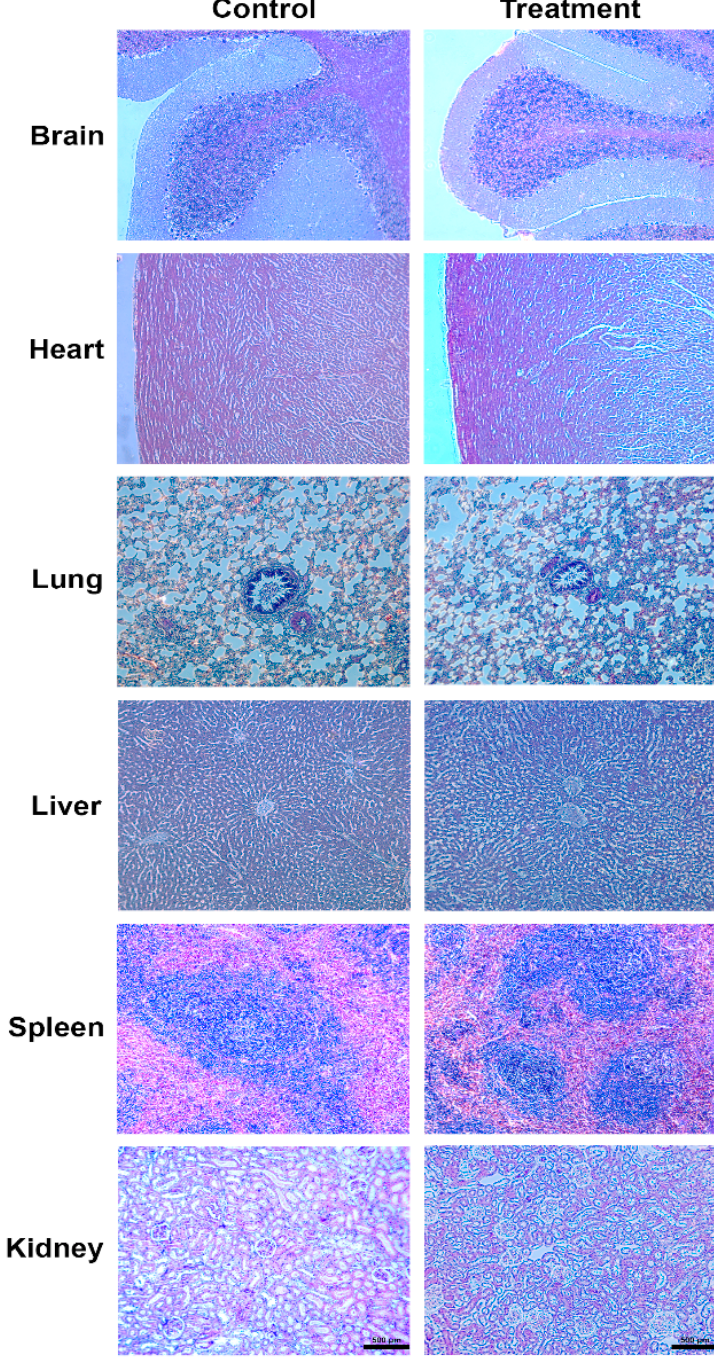
Figure 6. Histopathological examination of vital organs of rat treated with 2000 mg/kg of ZO essential oil, compared to the control group in acute oral toxicity study (H&E; ×100).